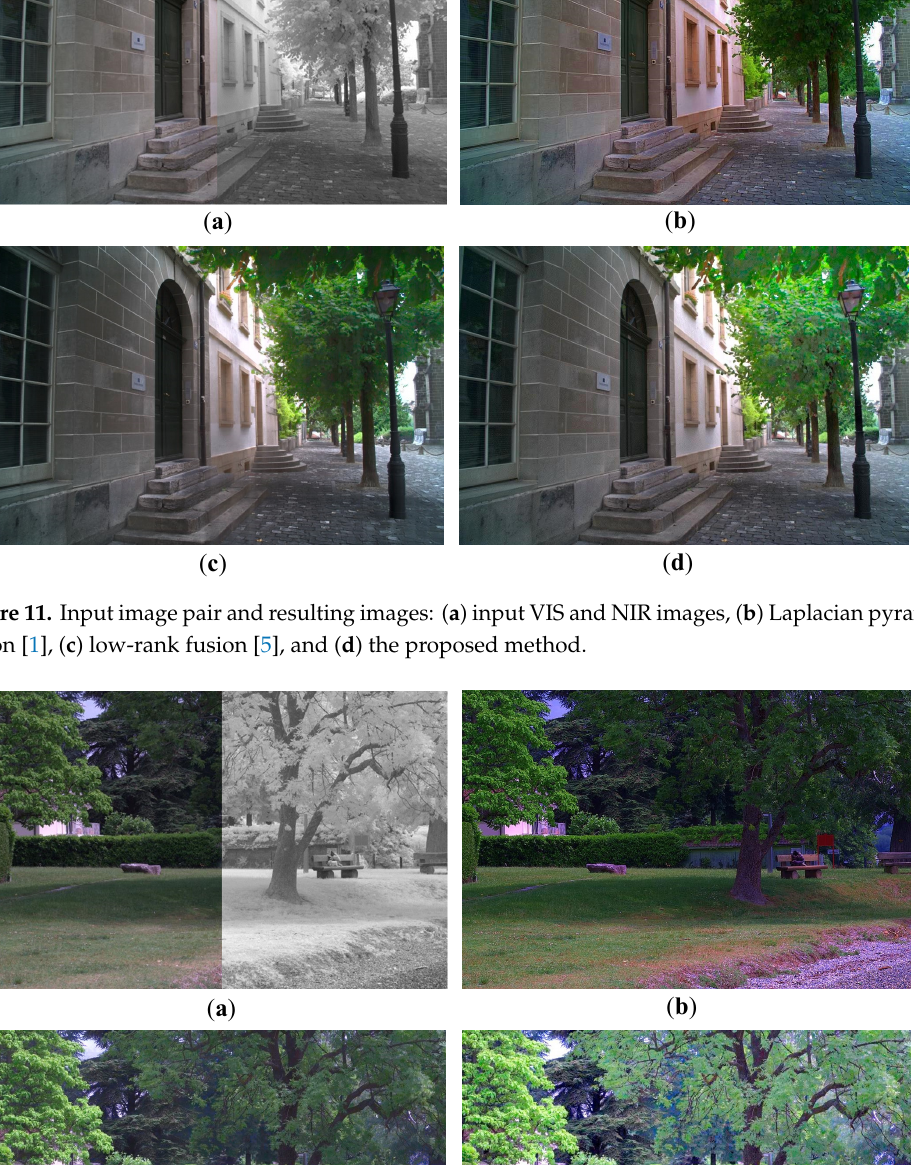
Figure 10. Input image pair and resulting images: (a) input VIS and NIR images, (b) Laplacian pyramid fusion [1], (c) low-rank fusion [5], and (d) the proposed method.